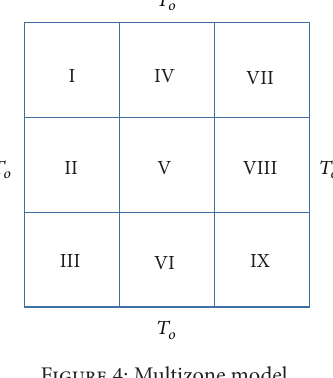
Figure 4: Multizone model.